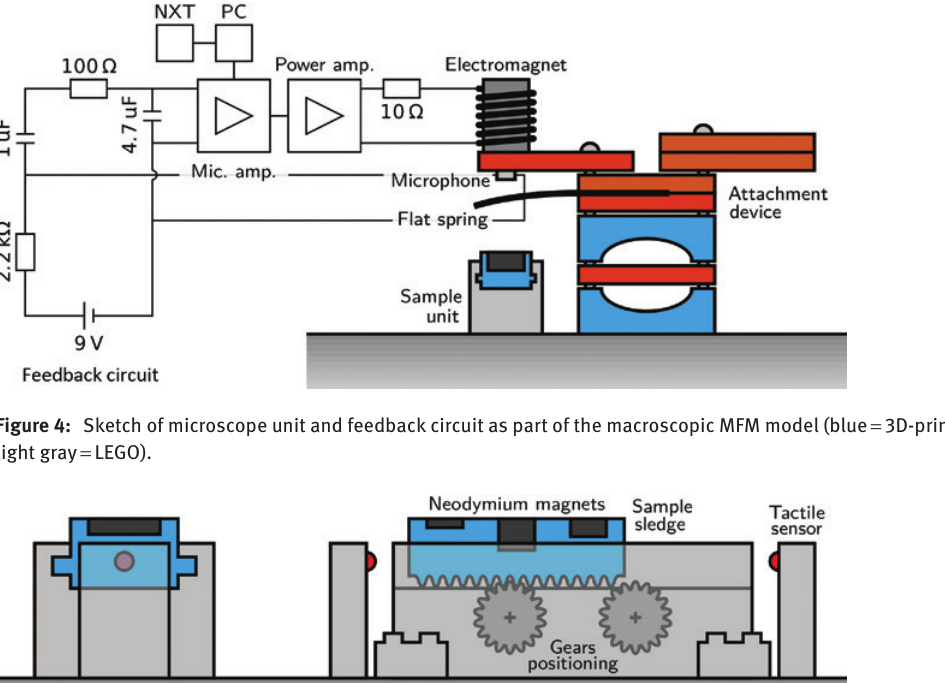
oscillates in its resonance frequency f . If the sample is 0 placed at a distance z below the cantilever, the resonance 0 frequency of oscillation changes according to equation (2). Note that the frequency shift occurring in the model can be derived along the same lines as for original